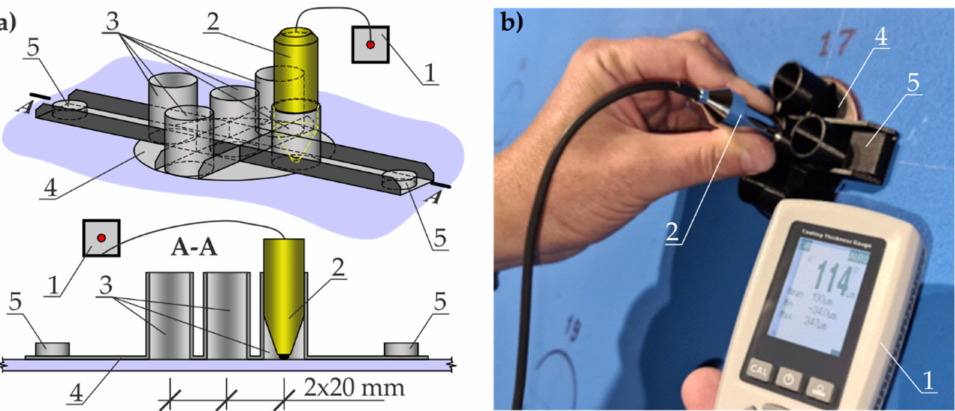
Figure 6. Test stand for measuring thickness of the paint coating by the electromagnetic method: ( a ) diagram of the measuring template; ( b ) view during the measurement taken on the sheet. 1— inductive thickness gauge; 2—measuring head of the thickness gauge; 3—head guides; 4—the measuring pattern; 5—neodymium